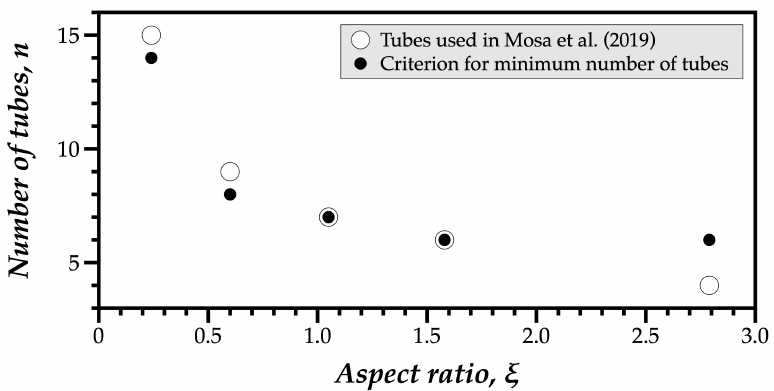
Figure 12. Minimum number of tubes above which the growth of Svelteness has diminishing